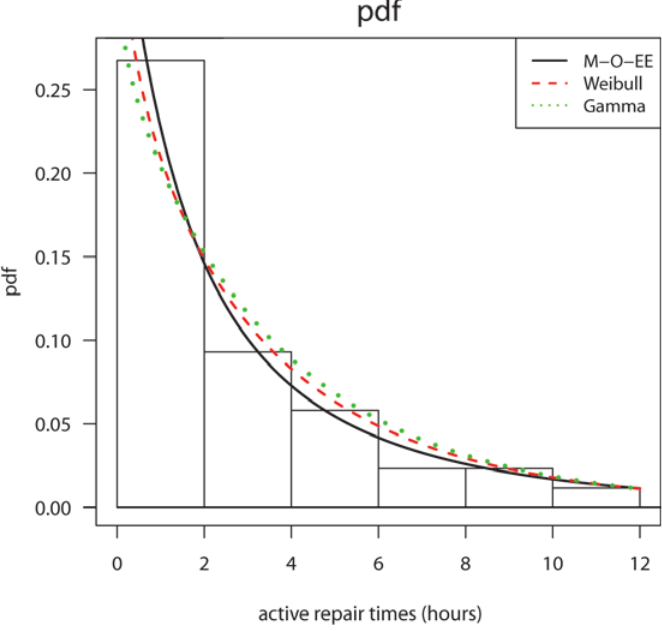
Figure 1 - Estimated pdf of the Marshall-Olkin extended exponential (M-O-EE), Weibull and gamma models for a real data